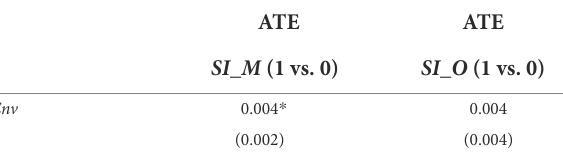
TABLE 6 The average treatment effect using propensity score